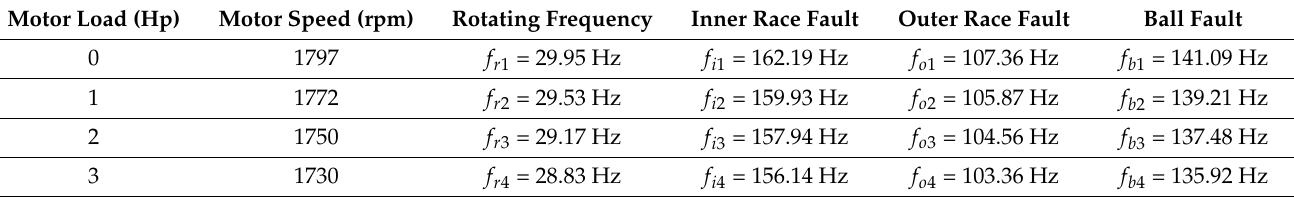
Table 4. Bearing fault characteristic frequency in case 2.